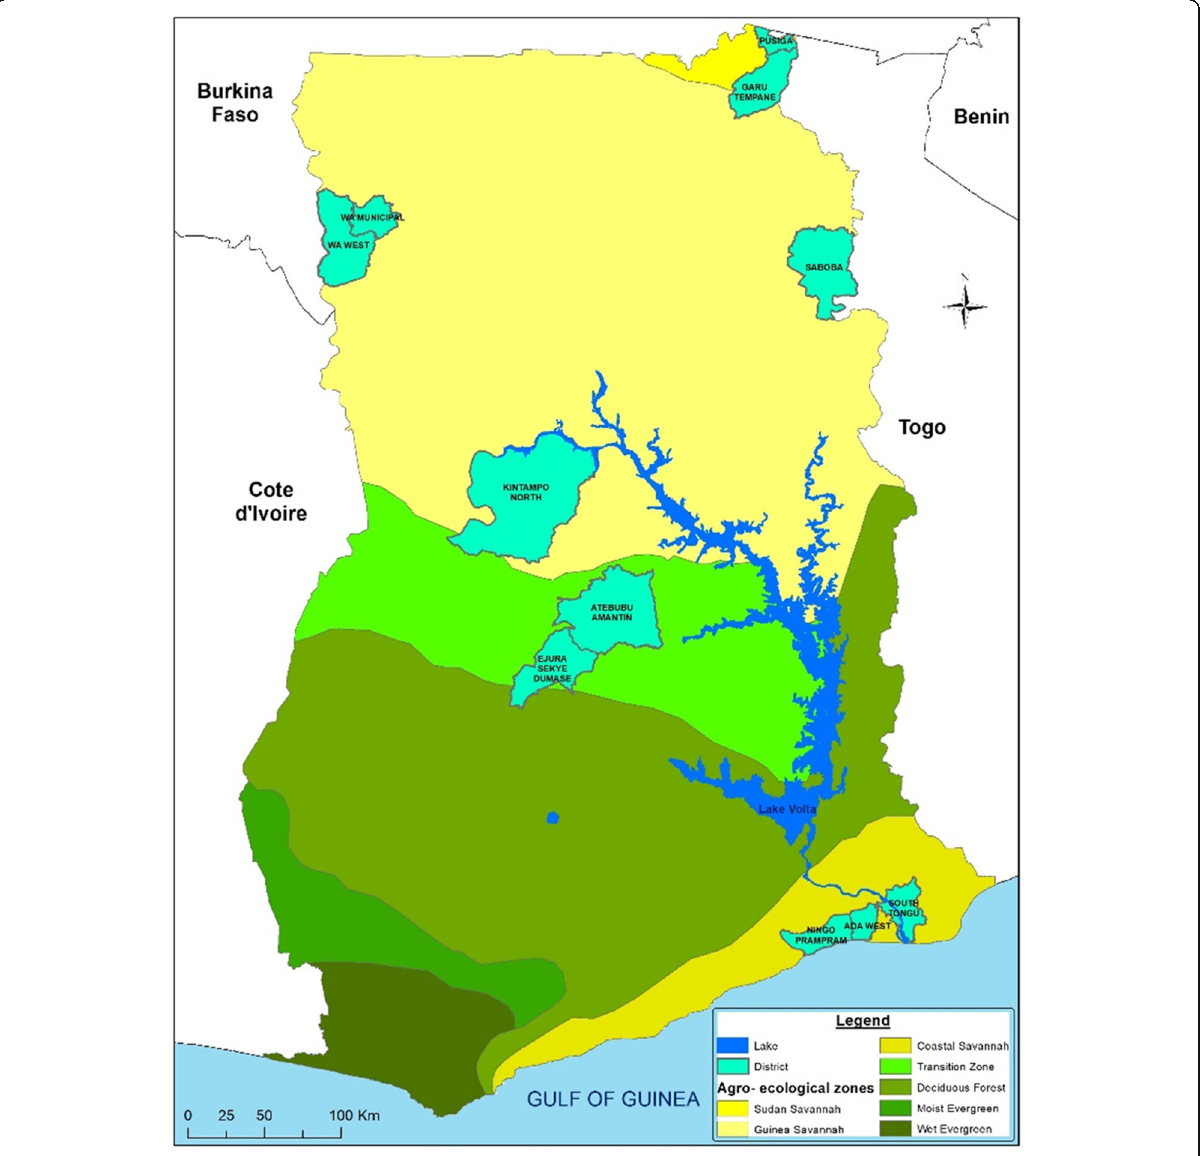
Fig. 1 Agro-ecological zones in Ghana and study districts. Districts (turquoise blue areas) were selected from the Sudan savannah (yellow area in the north-east corner), Guinea savannah (canary yellow area in the north), the forest to savannah Transitional zone (lime green area in the middle), and Coastal savannah (lemon yellow area in the south). Two to three districts were selected from each of the four agro-ecological zones noted for cattle production. Ghana is surrounded by Cote d ’ Ivoire to the west, Togo to the east, Burkina Faso to the north, and the sea Gulf of Guinea (Maya blue area) to the